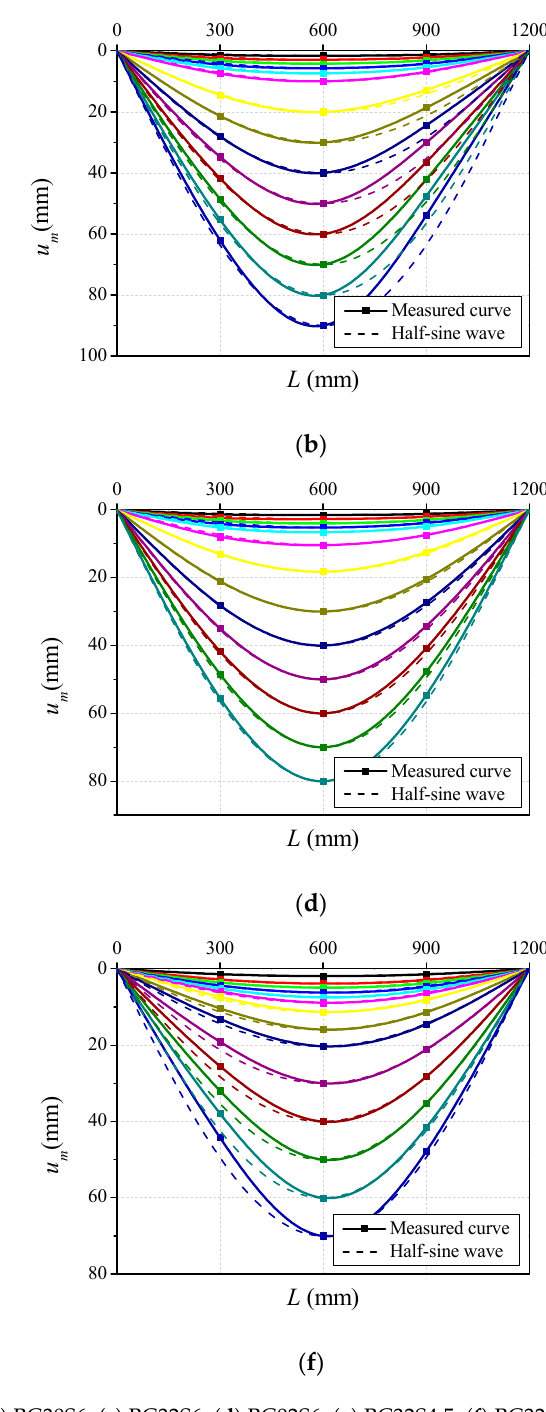
Figure 5. Typical overall lateral deflection curves. ( a ) BC20S6; ( b ) BC30S6; ( c ) BC32S6; ( d ) BC02S6; ( e ) BC32S4.5; ( f )